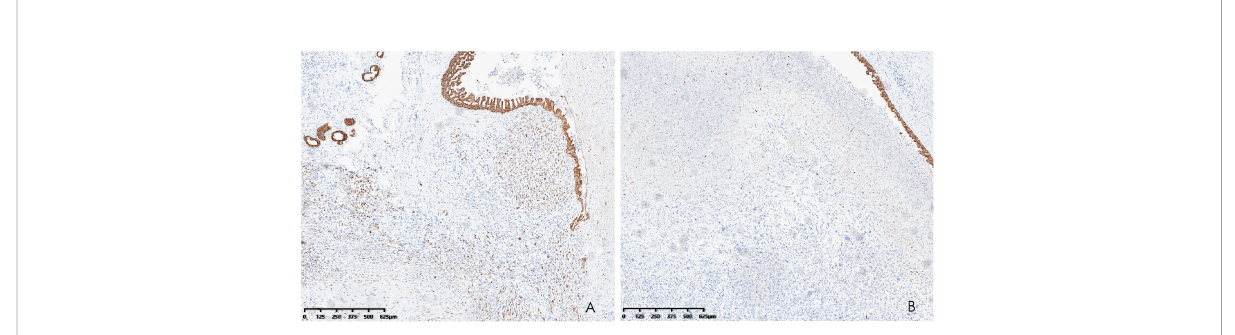
FIGURE 4 Immunohistochemistry demonstrated CK8/18 positivity in the tumor (A) and CK8/18 negativity for osteoclasts (B) (hematoxylin and eosin,